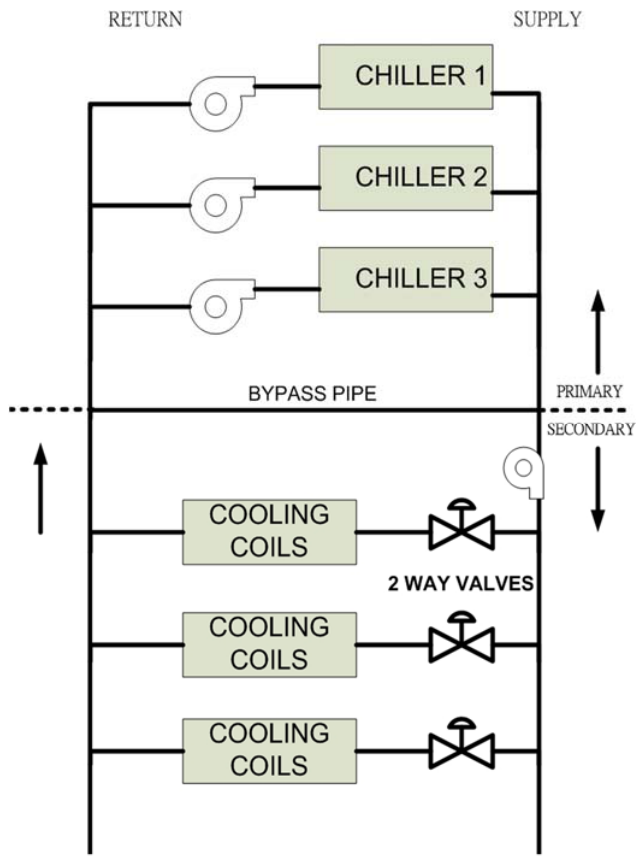
Figure 1. Decoupled system of a multiple-chiller system [28].